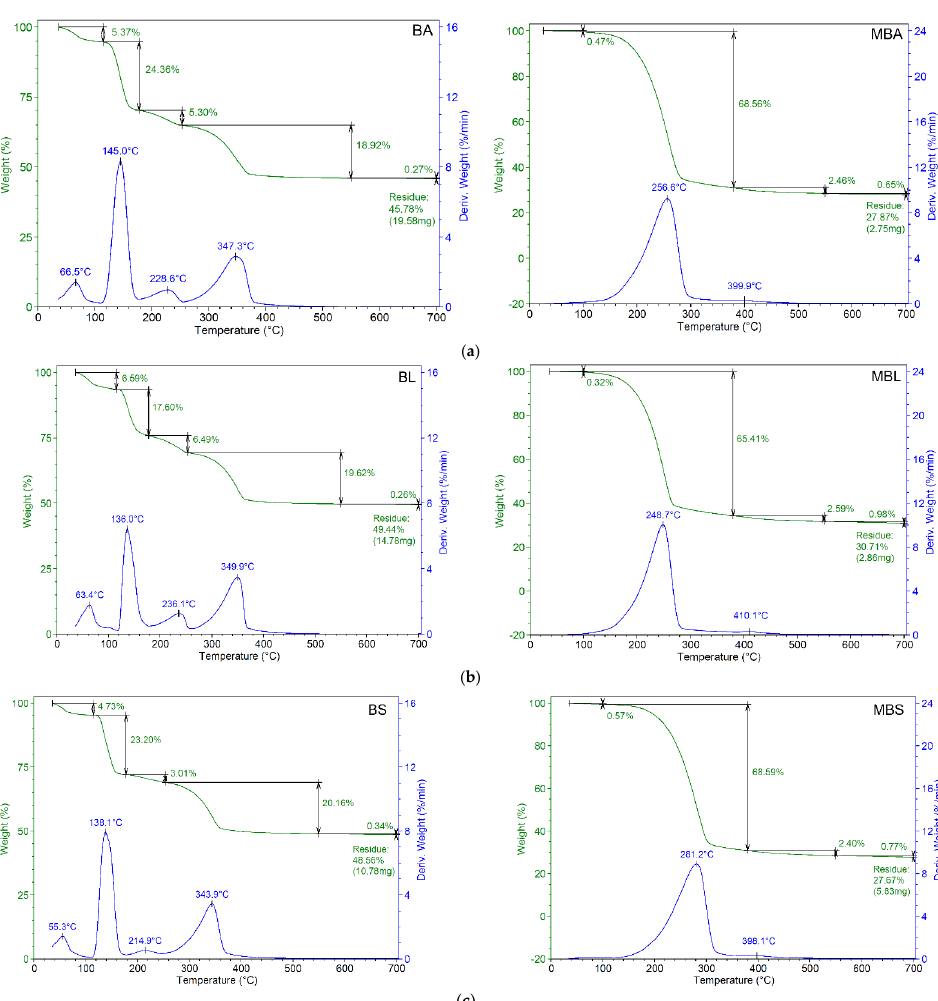
Figure 7. TGA curves of precipitates obtained from bacterial cultures on medium with or without urea and Ca 2+ : ( a ) TGA curve of precipitates obtained from B. amyloliquefaciens cultured on medium with (BA, left) or without urea and Ca 2+ (MBA, right); ( b ) TGA curve of precipitates obtained from B. licheniformis cultured on medium with (BL, left) without urea and Ca 2+ (MBL, right); ( c ) TGA curve of precipitates obtained from B. subtilis cultured on medium with (BS, left) or without urea and Ca 2+ (MBS, right). The deposits from bacterial culture on medium with urea and Ca 2+ were characterized by the occurrence of three main weight loss steps, at 115–178 °C, 253.5–550 °C, and over 700 °C. In contrast, the TGA of precipitates from control samples presented only two main weight loss steps, at approximately 250–280 °C and over 700 °C, their behavior being different as com ‐ pared with samples from cultivation on medium with urea and Ca 2+ . During the TG analysis, the samples exhibited a first slight weight loss in the range of RT–110 °C, representing approx. 4–7%, higher than those obtained for control samples, approx. 0.3–0.5%. Table 2. Results of TGA analysis applied to deposit samples from bacterial cultivation on medium with urea and Ca 2+ . Sample